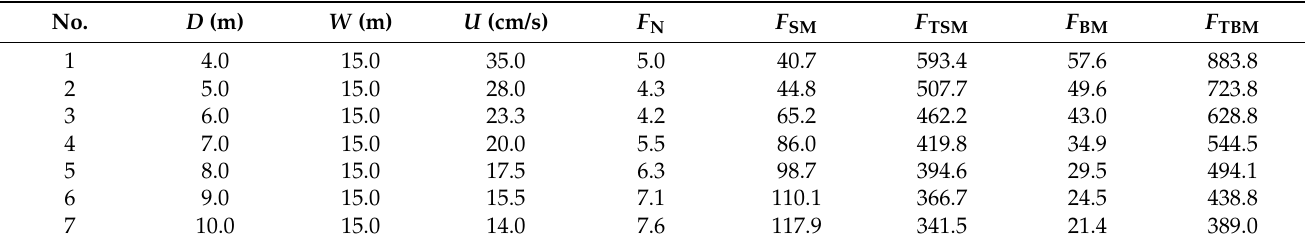
Table 3. Maximum tension on trash-blocking net and mooring system for different water depths.